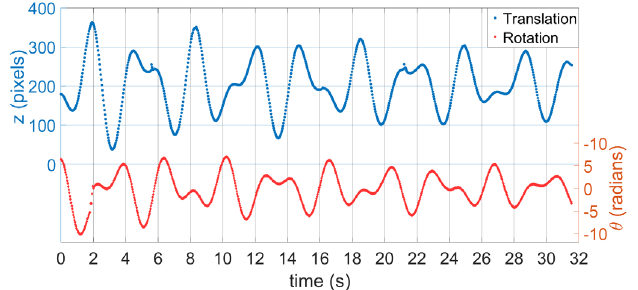
Fig. 6. Results of the main experiment, highlighting the “ Wilberforce effect ”